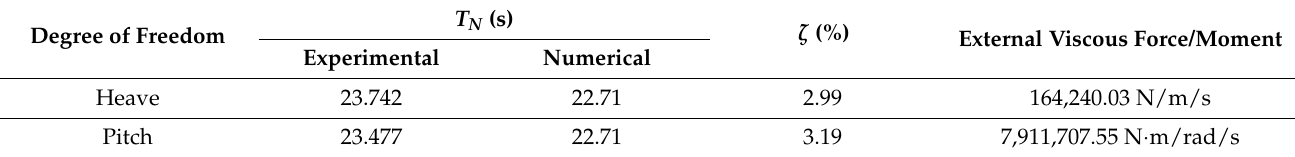
Table 3. Heave and pitch natural period and damping